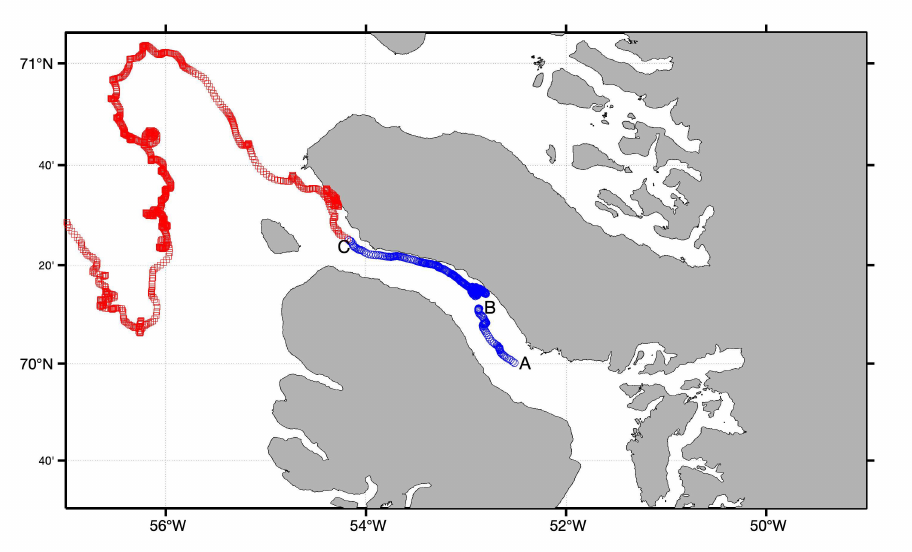
Figure 10. The segments of the buoy’s trajectory on the iceberg and drifting freely are indicated by the blue and red markers, respectively. The buoy was deployed on the iceberg at point A, fell into the water at point B and was reattached to the iceberg, and fell off the iceberg and began drifting unattended at point